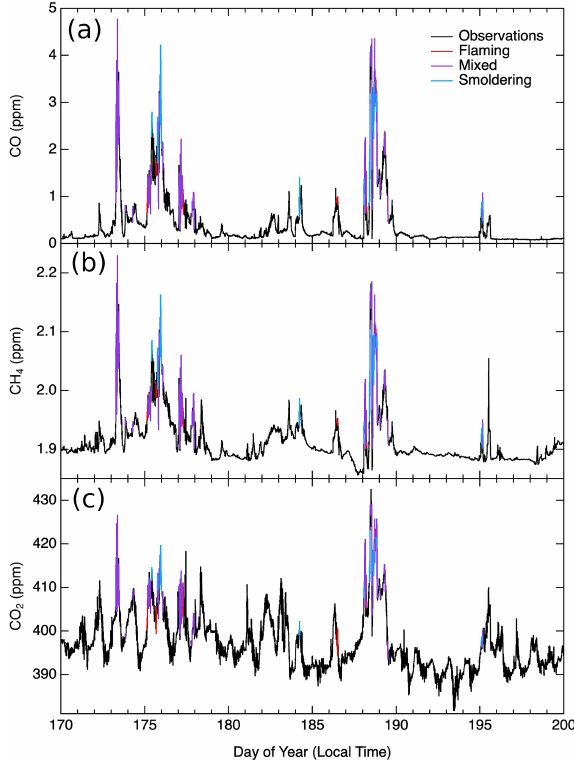
Figure 4. Trace gas observations at the CRV tower during the sum- mer of 2015 for (a) CO, (b) CH 4 , and (c) CO 2 mole fractions. The trace gas observations are shown at a 30s temporal resolution. Daily active fire detections derived from the MODIS sensors on Terra and Aqua satellites (MCD14ML C6) are shown in panel (d) .